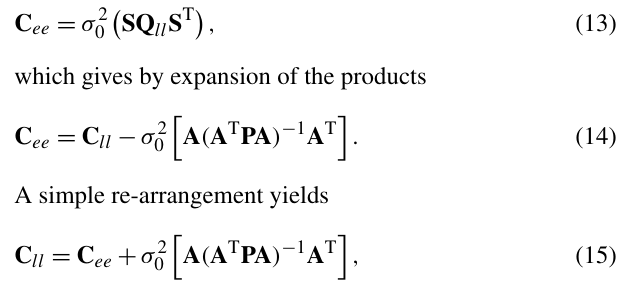
variance-/covariance matrix can be compiled according to Eq. (10).